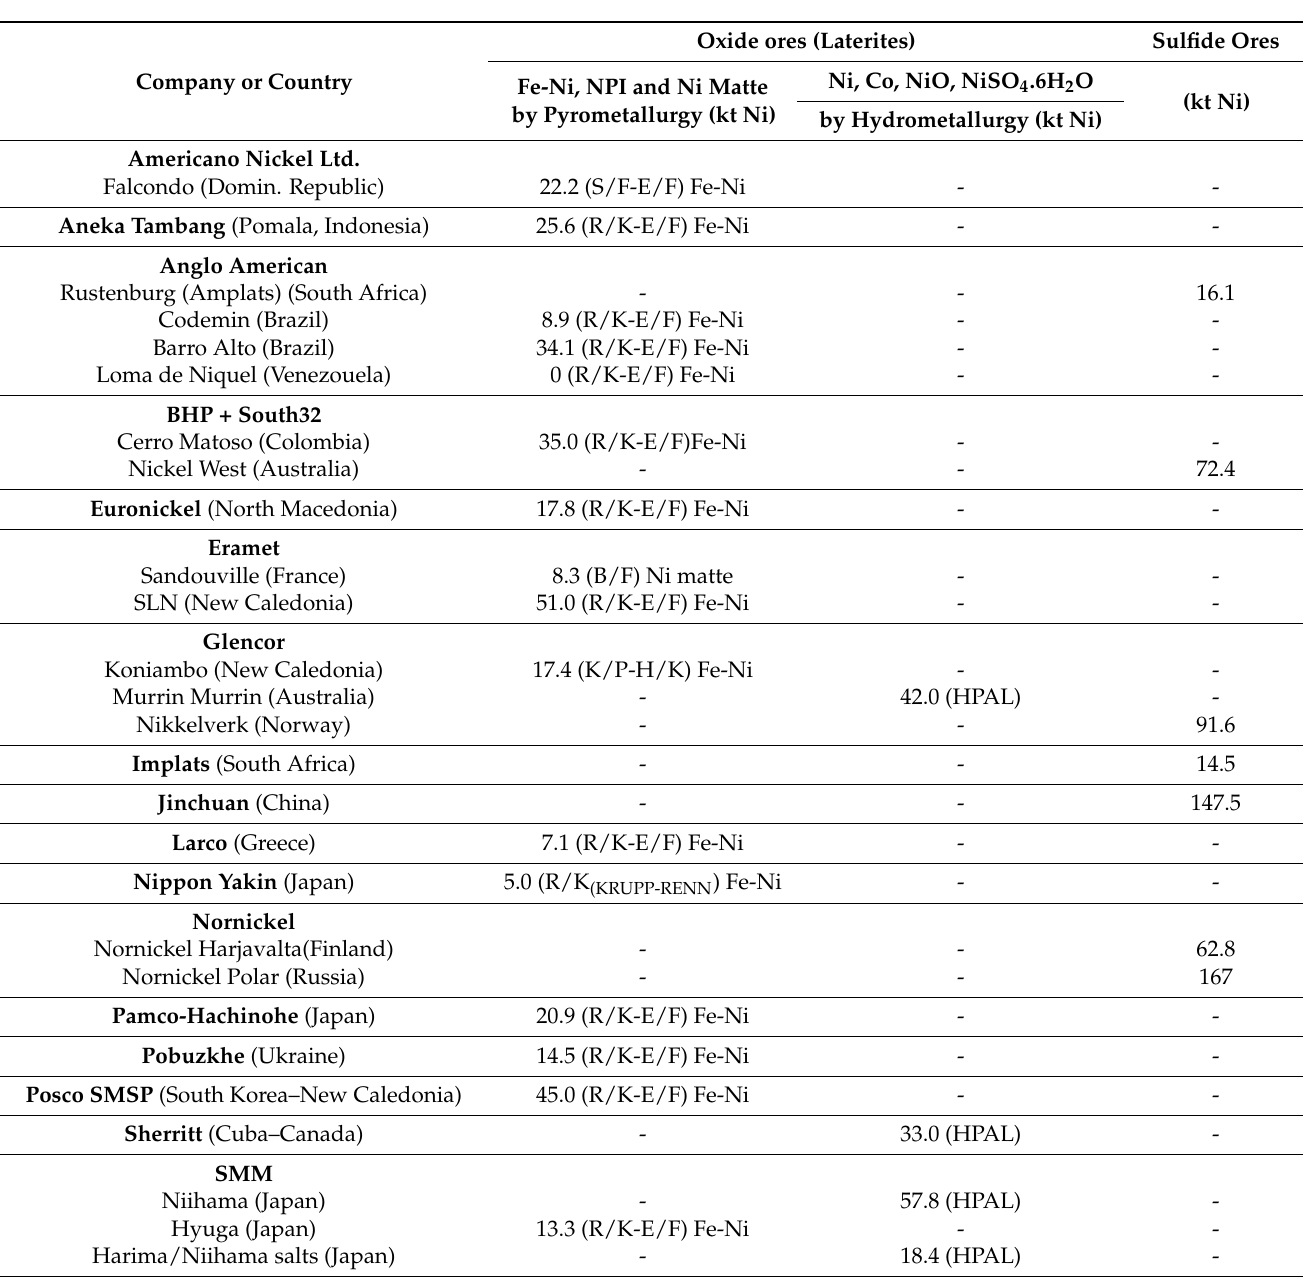
Table 4. World primary Ni production by country, company, ore category, and processing method of laterites